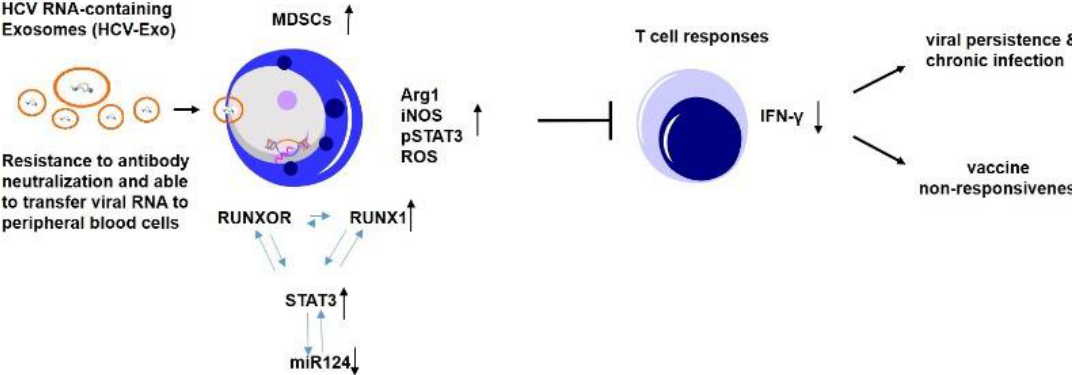
Figure 7. A model depicting the role of RUNXOR/RUNX1 in MDSC differentiation and suppressive functions. A model describing the role of RUNXOR–RUNX1 axis in MDSC development and the mechanism by which it suppresses host immune responses through regulating STAT3/miR-124. HCV infection can induce MDSC differentiation and production of immunosuppressive molecules, such as Arg1, iNOS, pSTAT3, and ROS, via induction of the RUNXOR–RUNX1 axis. RUNXOR and RUNX1 can reciprocally regulate each other’s expression and regulate STAT3–miR124 axis, which in turn promotes MDSC differentiation and its suppressive functions. This path will lead to the inhibition of T cell responses, thus potentially contributing to viral persistence and vaccine non-responsiveness during HCV infection.